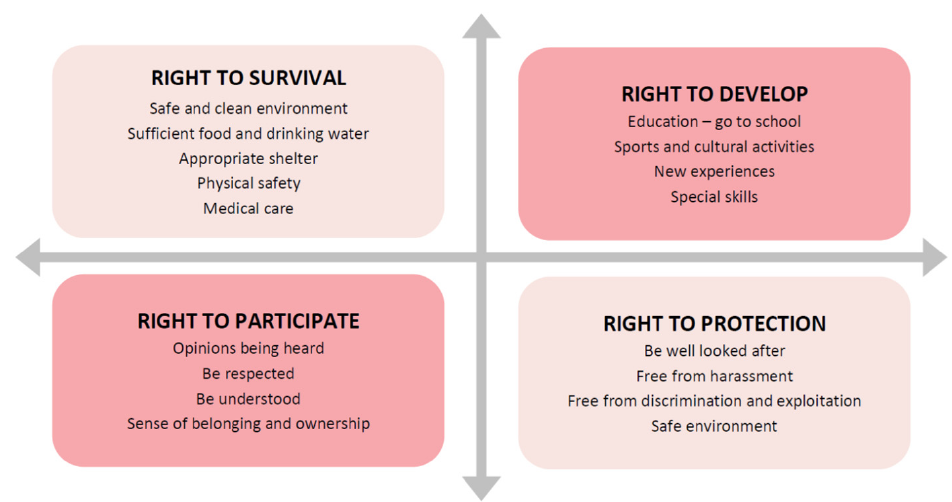
Figure 1. Infogram from RSPO 2020 Guidance on Child Rights for Palm Oil Producers . Reprinted with permission from ref. [73] (p. 3). 2020 RSPO.